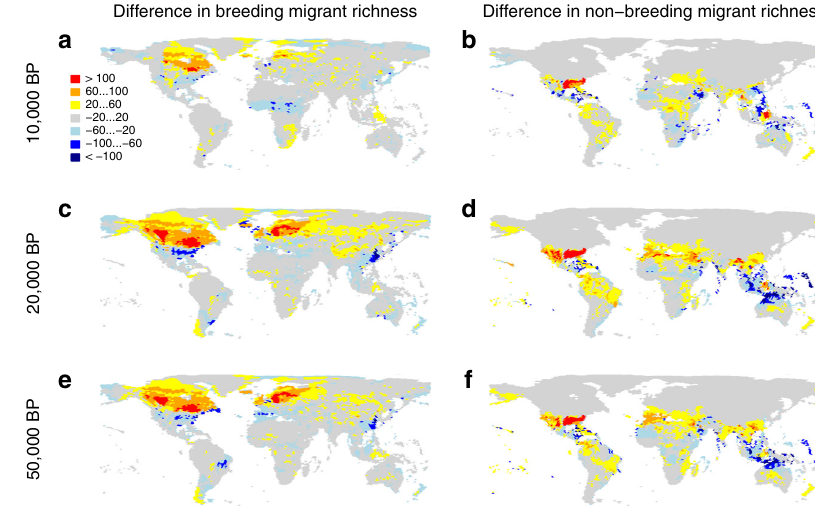
Fig. 2 Contrast between past and present simulated patterns of migratory bird diversity. The global patterns were computed as the predicted richness in the present minus the predicted richness in the past, i.e., predicted number of species per hexagon: 10,000 years before present ( a , b ); 20,000 BP ( c , d ); and 50,000 BP ( e , f ). BP: Before Present. Red areas had fewer species in the past than today, blue areas more.